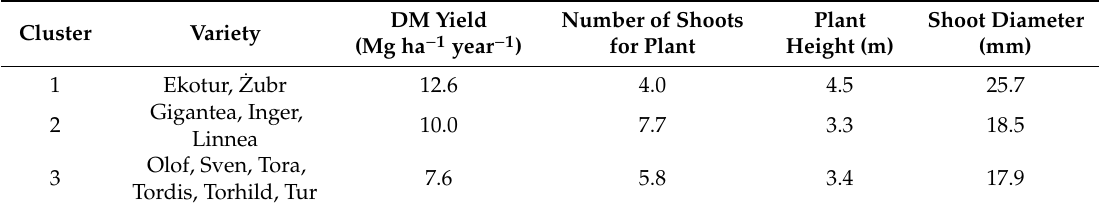
Table 4. Yield of biomass and biometric features of willow crops in separated